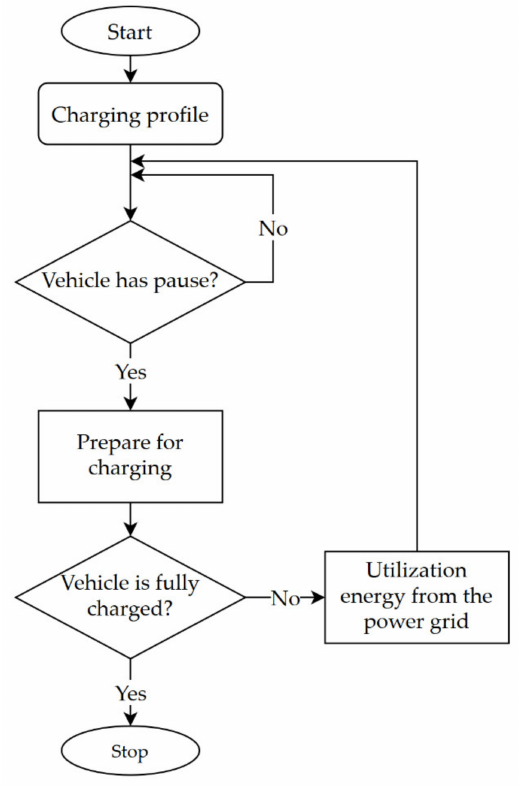
Figure 14. The control algorithm for model